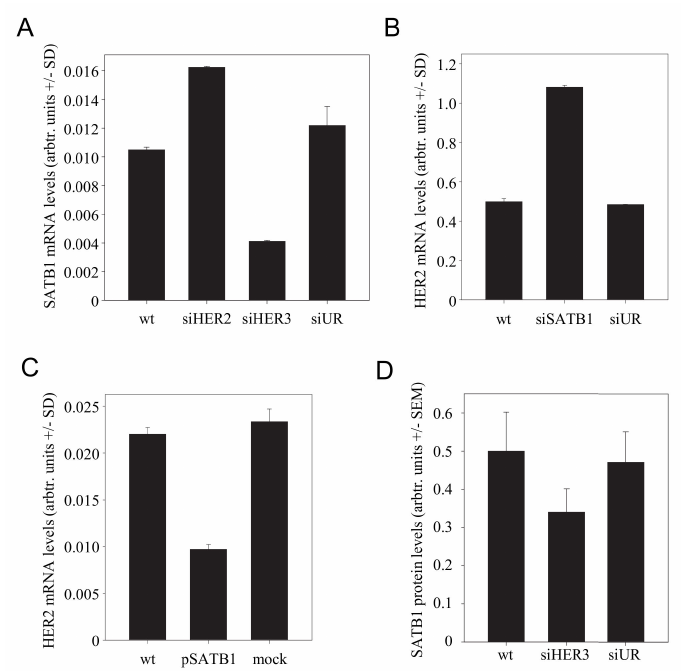
Figure 4. Effect of SATB1 in the HER3/HER2 regulation network. ( A ) Alterations in SATB1 mRNA levels upon knockdown of HER2 or HER3. ( B ) SiRNA-mediated SATB1 knockdown leads to increased HER2 mRNA levels. ( C ) SATB1 overexpression decreases HER2 mRNA levels. ( D ) SATB1 levels in the tumor xenografts from the PEI/siRNA therapy experiment, as determined by